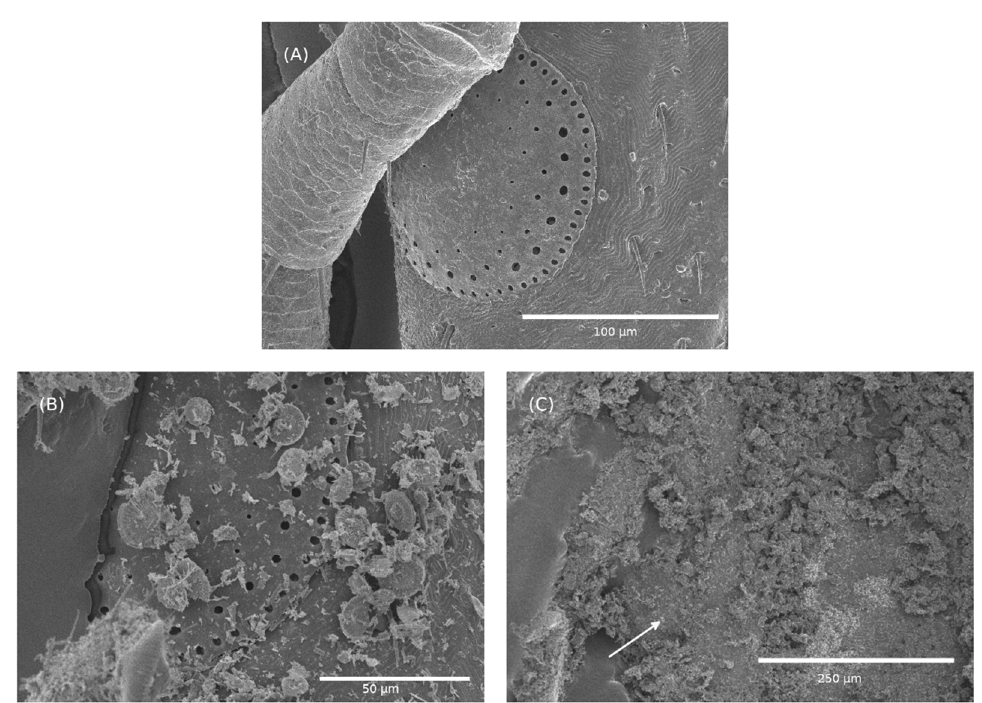
Figure 5. Tick spiracular plate ( A ) untreated and ( B , C ) treated with Celite 610. The arrow in ( C ) points to the location of the spiracular plate almost completely obstructed by Celite.